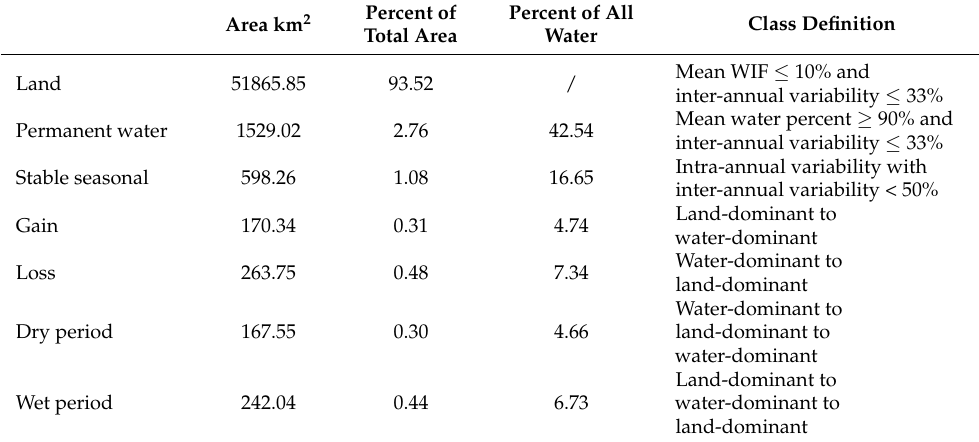
Table A1. The statistics of surface water area for different dynamic types in the